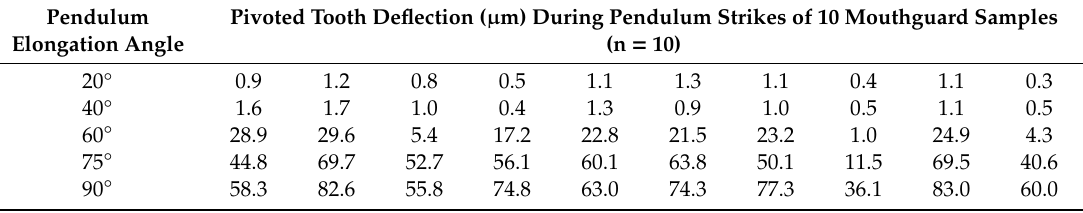
Table 5. Nylon mesh mouthguard measurements: Average values of maximum amplitudes (mean of 5 measurements per mouthguard and angle) of the pivoted tooth (reflection foil) deflection obtained during measurements with energy blows from 20–90 degree pendulum elongation angles.